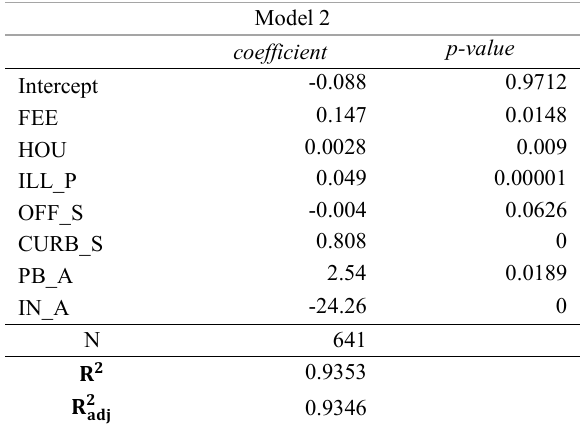
Table 3 Several variables such as average distance to the alternative parking choice, the average fee of off-road parking, numbers of hospital are removed due to the insignificance